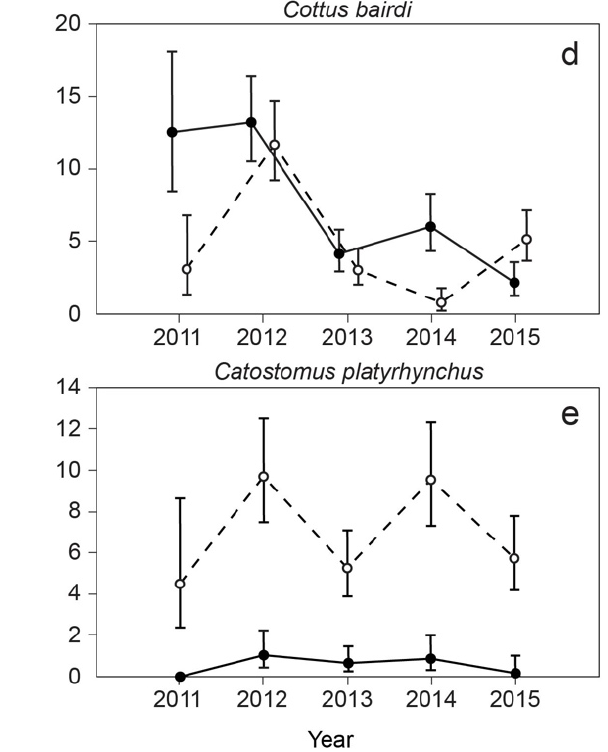
Figure 4. Mean fish abundances by species per year for the five species in this study ( a – e ). Error bars are 95% confidence intervals of the mean. Adults are represented by the solid line and solid circles, and juveniles are represented by the dashed line and open circles.